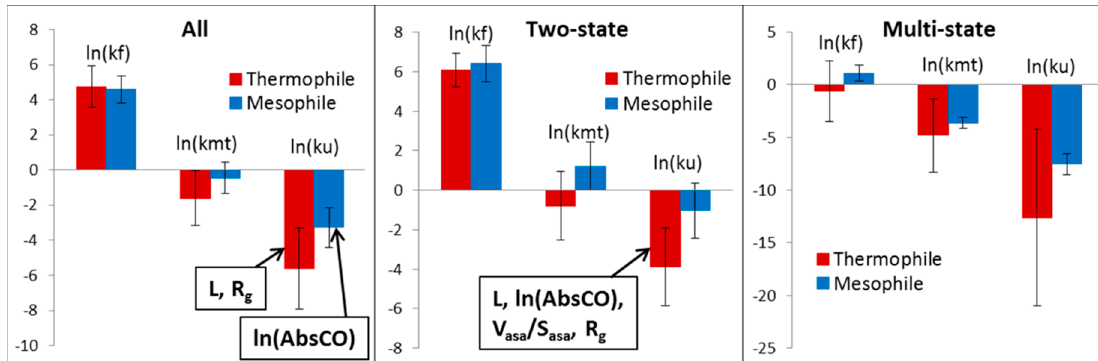
Figure 6. The average values of the logarithm of the unfolding and folding rates for thermophilic and mesophilic two- and multi-state proteins. Structural parameters that better correlate with the logarithm of the unfolding rate are outlined in a rectangle.